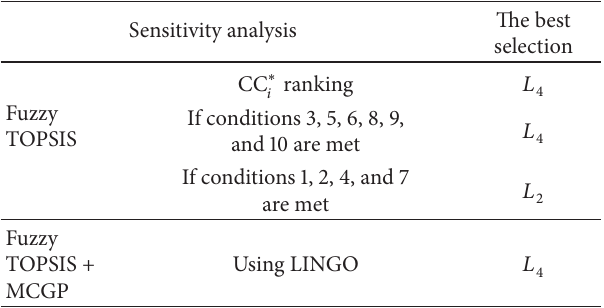
Table 12: Comparison of logistics centers location selection meth- ods and sensitivity